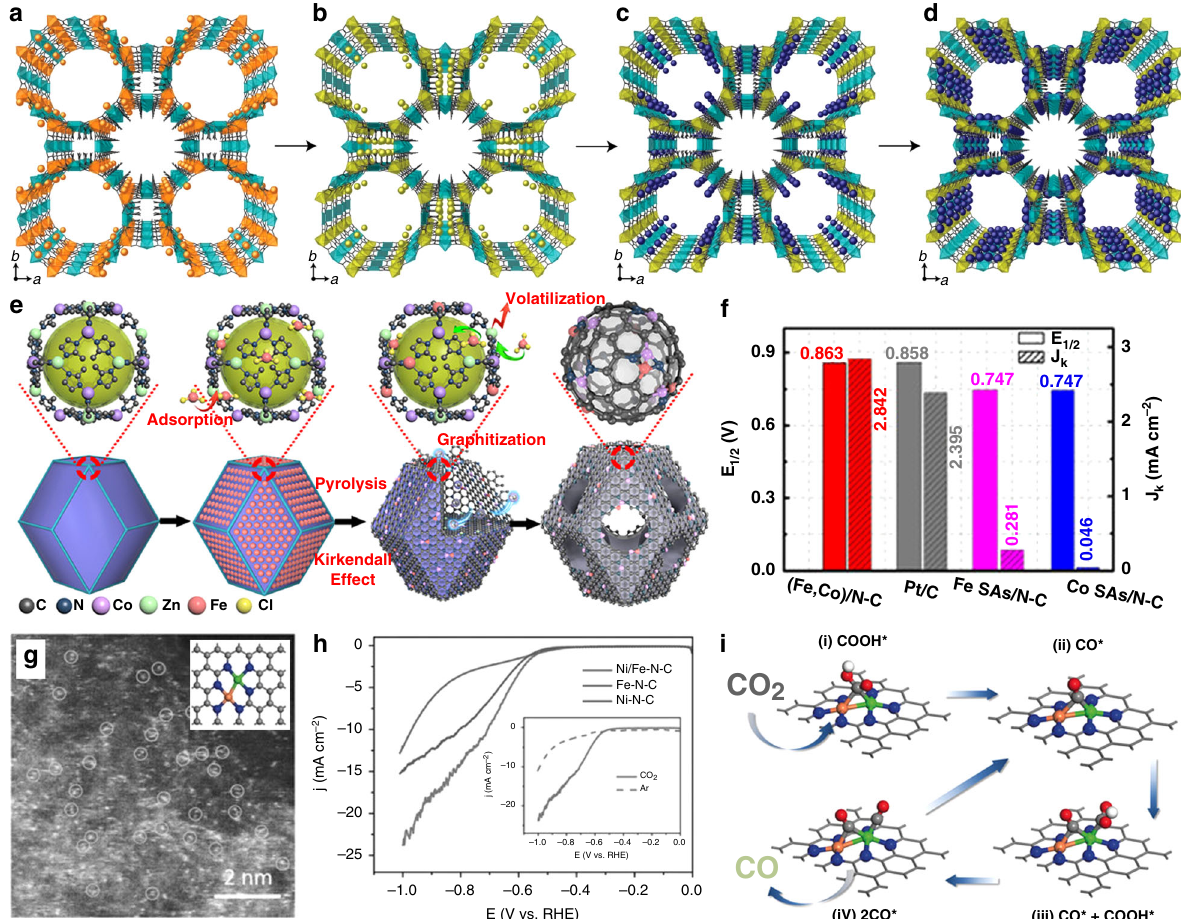
Fig. 5 The host – guest strategy. a – d Design approach showing the structures of 1 – 4 determined by single-crystal X-ray diffraction from the three-step post-synthetic process consisting of a transmetallation 1 ( a ) to give 2 ( b ), an exchange of the Ni II cations of the pores by [Pd II (NH 3 ) 4 ] 2 + ones yielding 3 ( c ) and the fi nal reduction process affording 4 ( d ). Reprinted by permission from Macmillan Publishers Limited: Springer Nature, Nature Materials , ref. 85 (Fortea-Pérez et al). Copyright (2017). e Preparation of (Fe, Co)/N – C. f Comparison of E 1/2 and J k for (Fe, Co)/N – C and other samples for ORR. Reprinted by permission from ref. 19 . Copyright (2017) American Chemical Society. g AC-HAADF-STEM images of Ni/Fe – N – C. The inset of ( g ) is the structure model of Ni – Fe dual atoms (Fe: orange; Ni: green; N: blue; C: gray). h Linear sweep voltammetry (LSV) curves for CO 2 reduction over Ni/Fe – N – C and other samples. Inset: LSV comparison for Ni/FeN – C in Ar- and CO 2 -saturated 0.5 M KHCO 3 solution. i The catalytic mechanism on Ni/Fe – N site (based on the optimized structures of adsorbed intermediates COOH* and CO*). Adapted and reprinted with permission from ref. 28 . Copyright (2019) John Wiley & Sons, Inc.